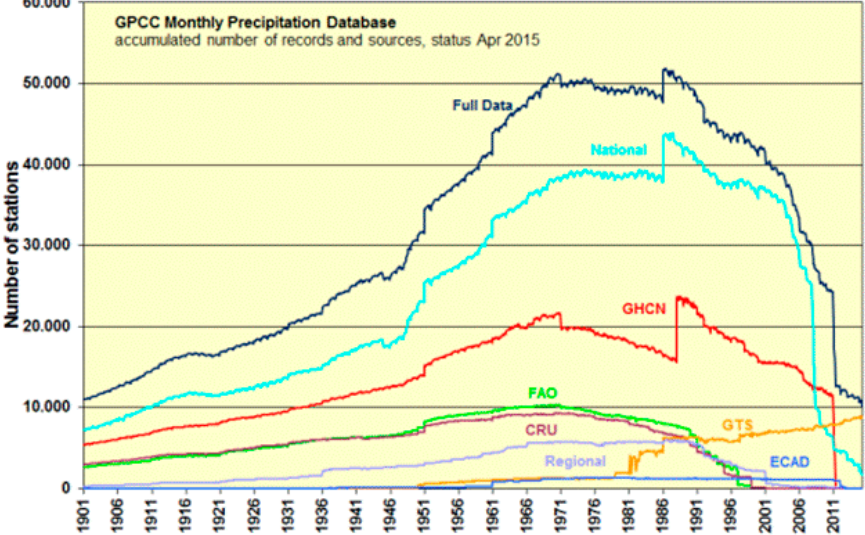
Figure 1. Total number of stations with monthly precipitation data over time (shown since 1901) in the Full Data Base of the Global Precipitation Climatology Centre (GPCC) according to the different data sources.